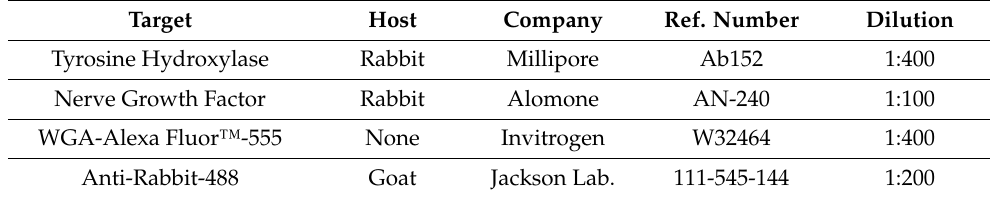
Table 1. List of primary and secondary antibodies that were used for immunofluorescence analysis.